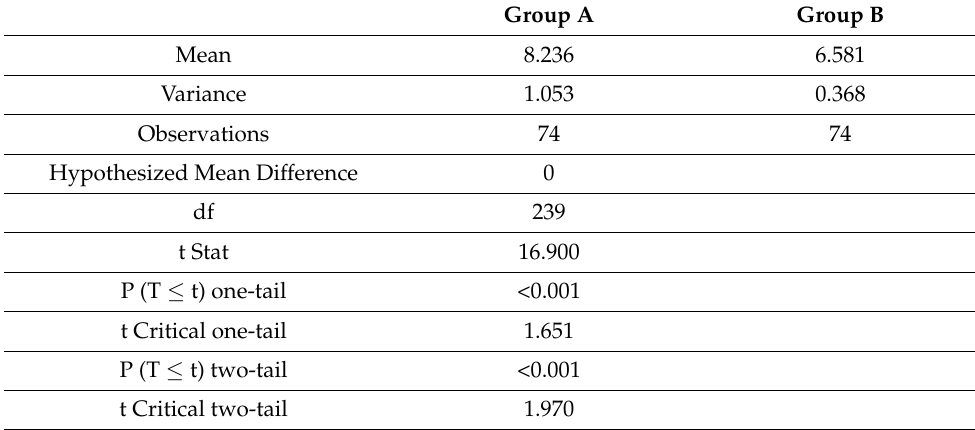
Table 4. t -test results of